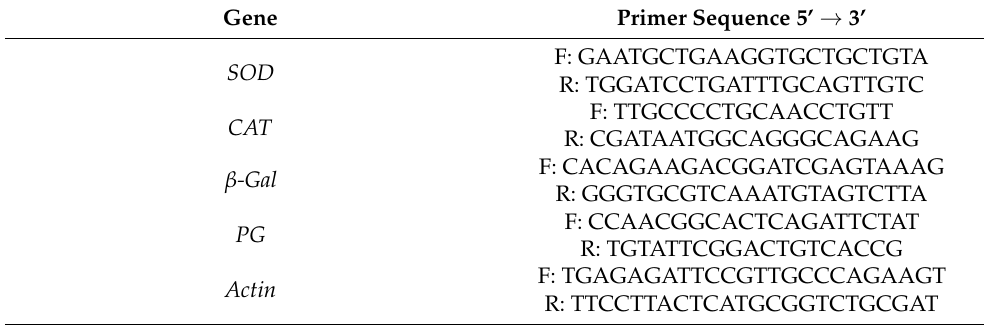
Table 1. Sequences of primers used in RT-qPCR of relative gene expression in